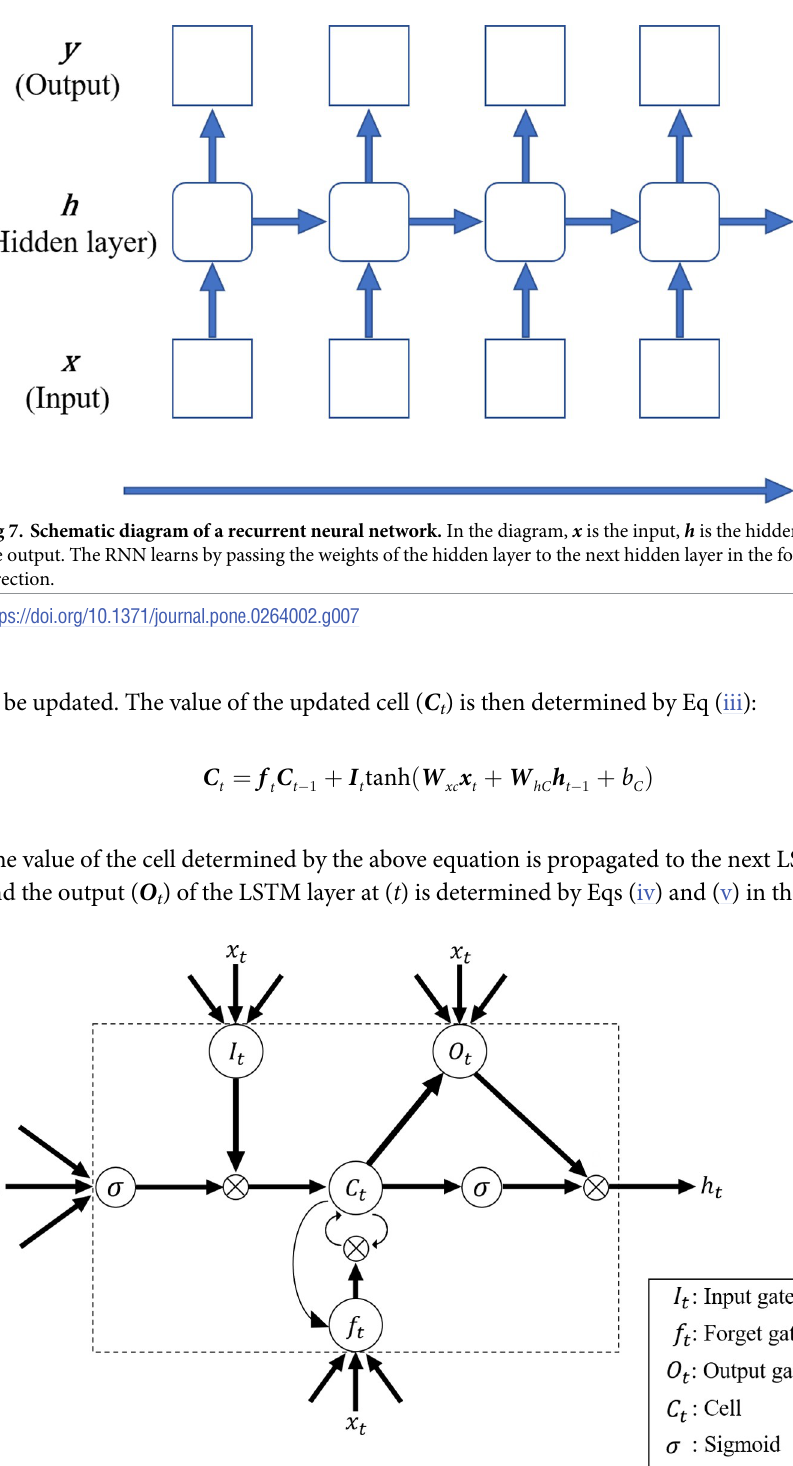
Fig 8. Diagram of the long short-term memory principle. Input, forgetting, and output gates are used to determine the information to be input into, retained, and output from the cells, enabling the learning of sequential data over a long period of